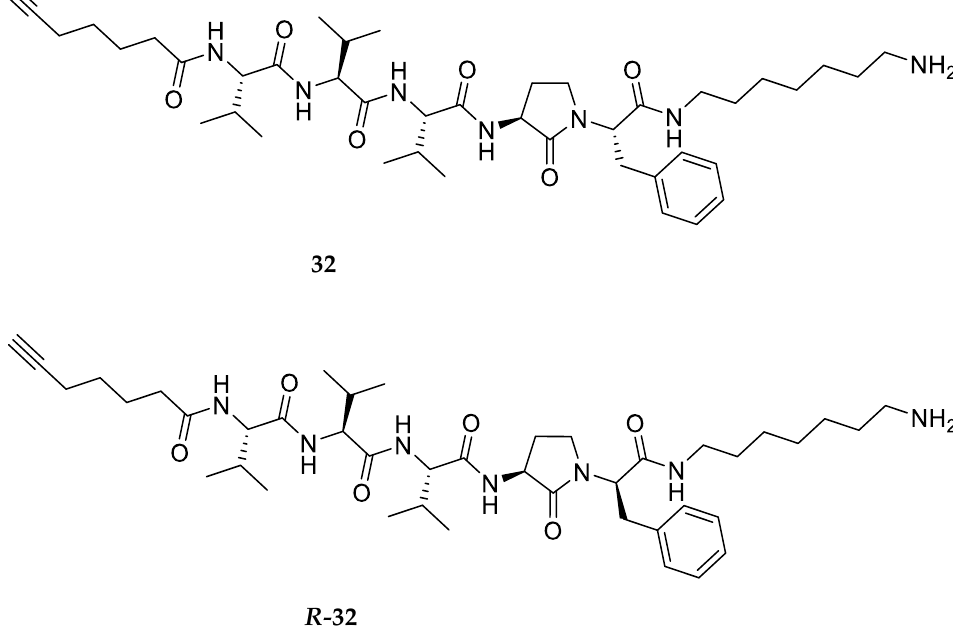
described above for the synthesis of peptide 18 using Fmoc-Agl-Ala-OH (359 mg, 3 eq.) in